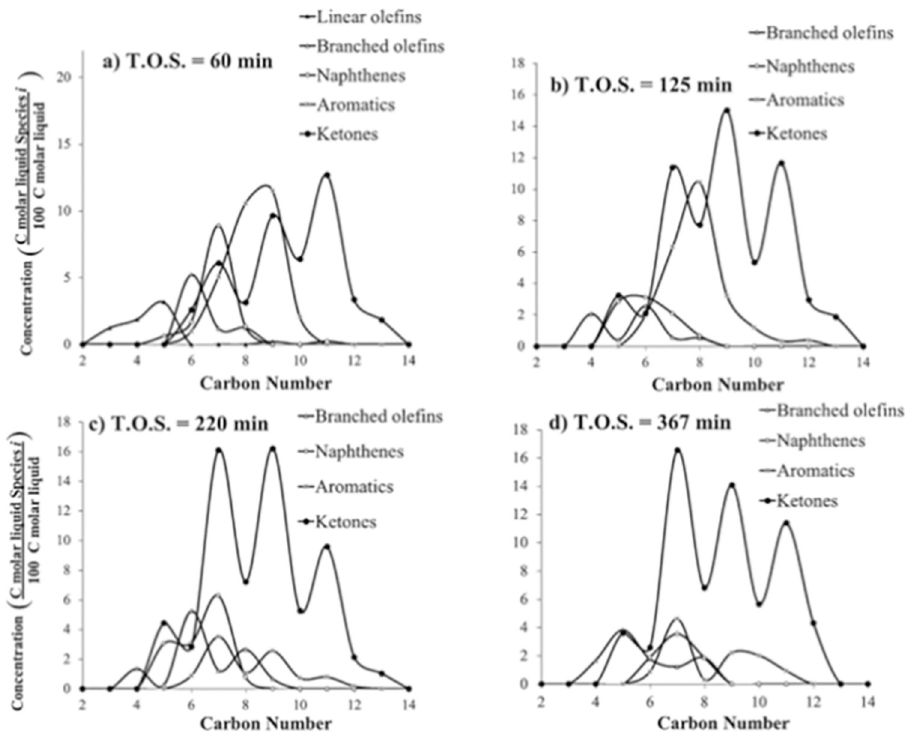
Fig 13. Liquid carbon product distribution of mixed-ketone reaction over HZSM-5(280), WHSV = 1.9 h –1 , T = 590˚C, and P = 101 kPa